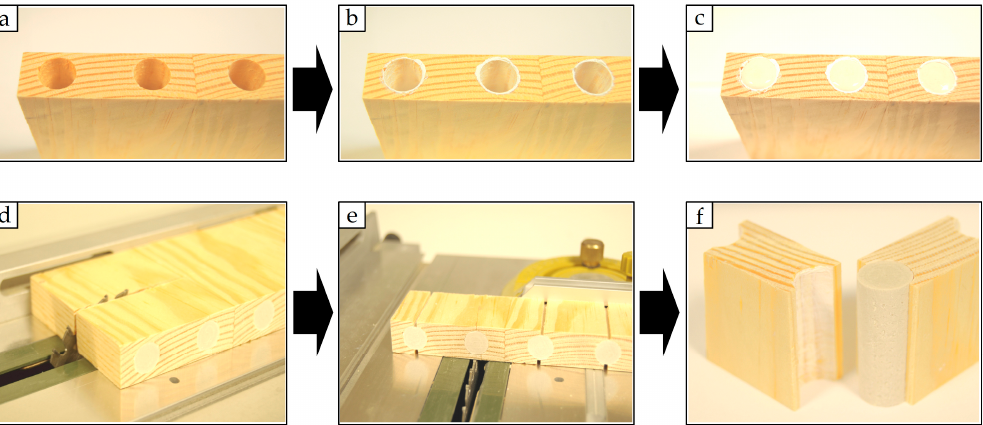
Figure 3. Scheme of preparation and extraction of the hole counter-samples ( a —wood sample with drilled holes, b —wood sample with applied coating, c —wood sample immediately after filling the holes, d , e —cutting of wood samples with hardened casts, f —the final shape of extracted counter-sample).